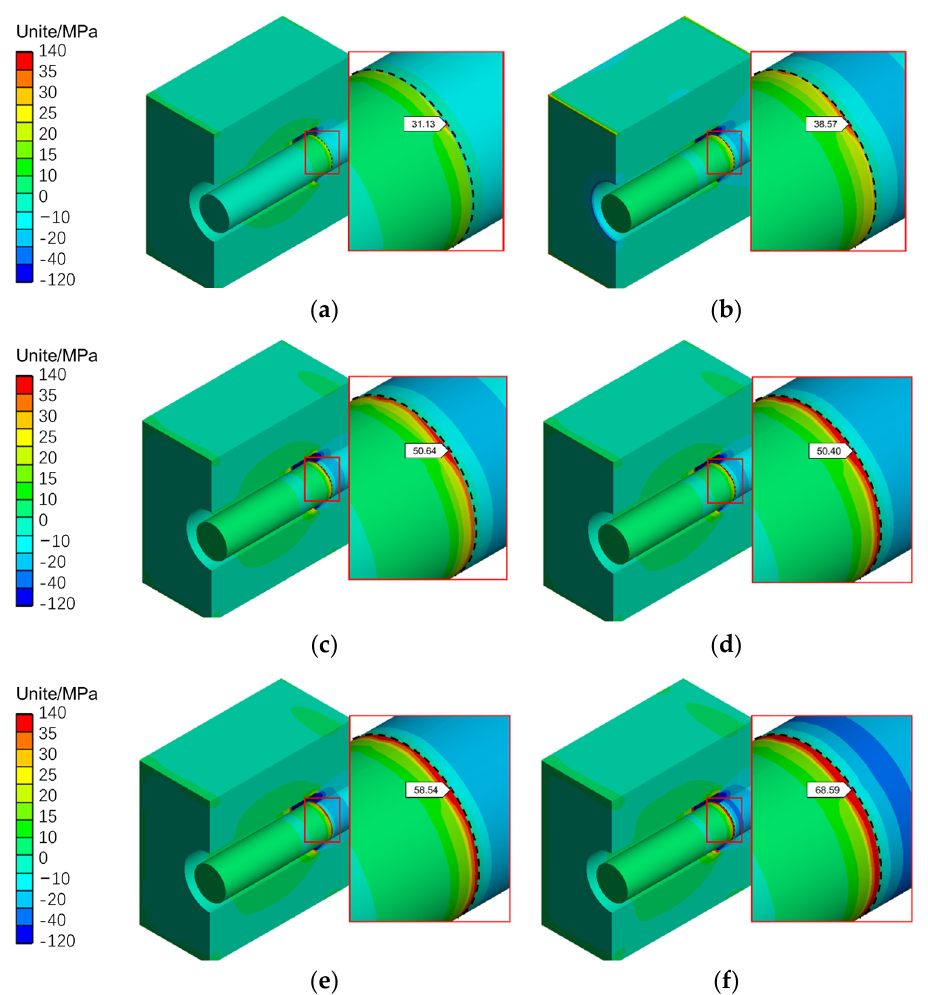
Figure 15. Core surface normal stress distribution. ( a ) Simulation test 1; ( b ) Simulation test 2; ( c ) Simulation test 3; ( d ) Simulation test 4; ( e ) Simulation test 5; ( f ) Simulation test 6.